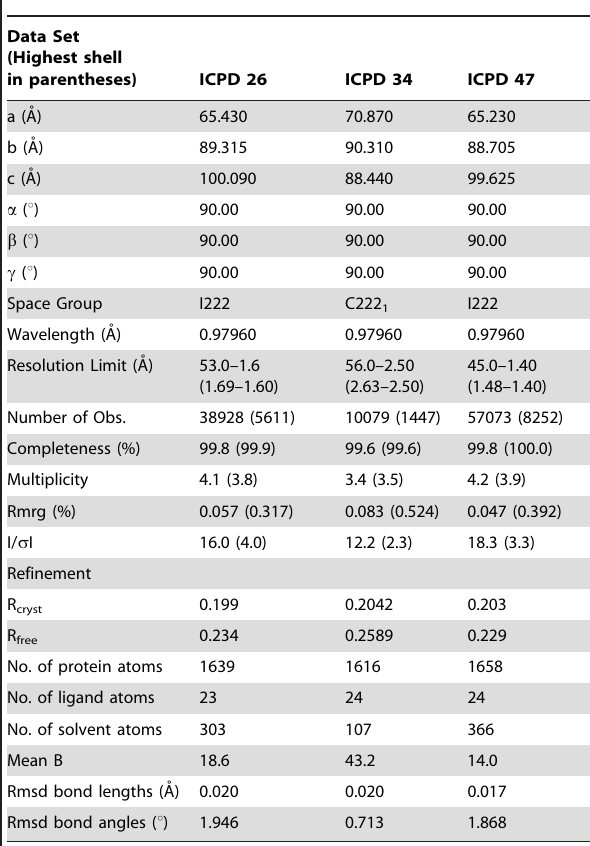
Table 1. Crystallographic statistics.